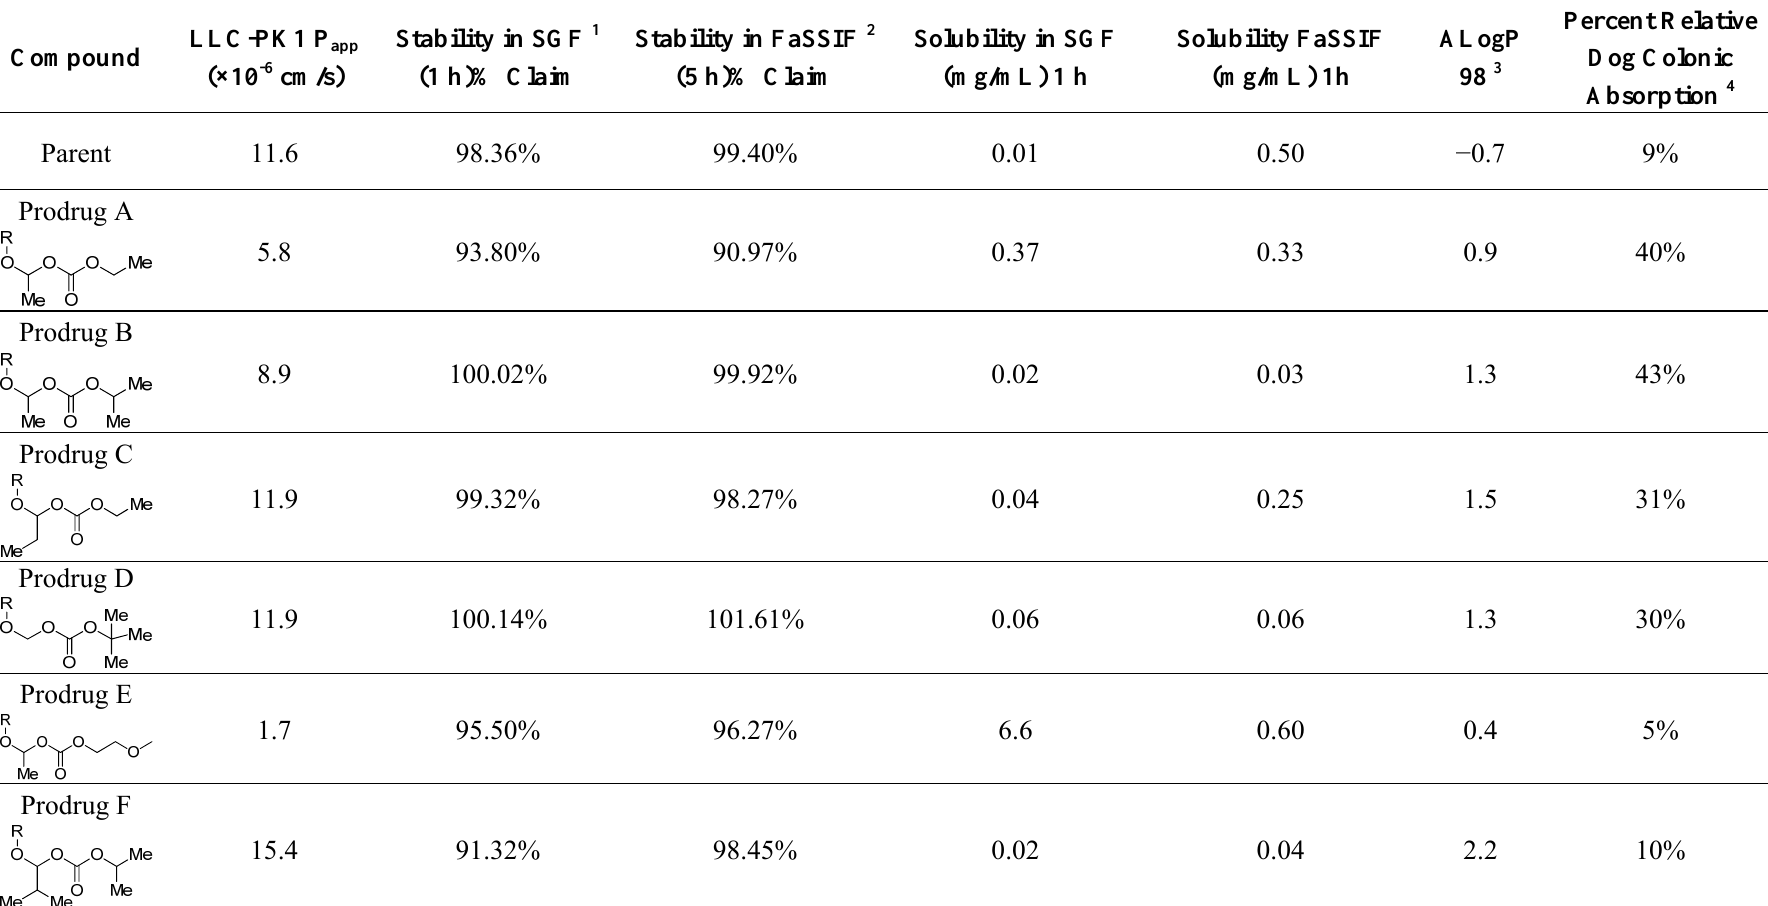
Table 2. Physicochemical properties of the prodrug molecules compared to that of the parent drug molecule in terms of solubility in simulated gastric fluid (SGF), simulated fasted state intestinal fluid (FaSSIF), permeation values from LLC-PK1 assay (with cyclosporine A), calculated partition coefficient (ALogP 98) and dog colonic